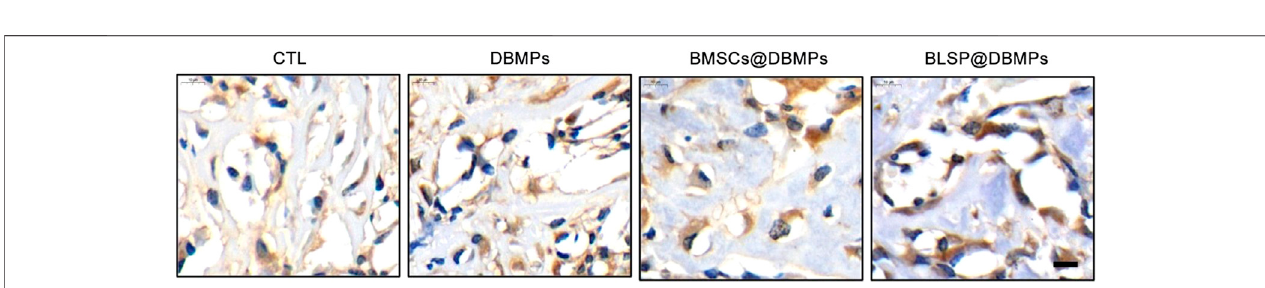
FIGURE 8 | Immunohistochemical staining of Ocn in the repaired bone defect area of each group at postoperative day 14.